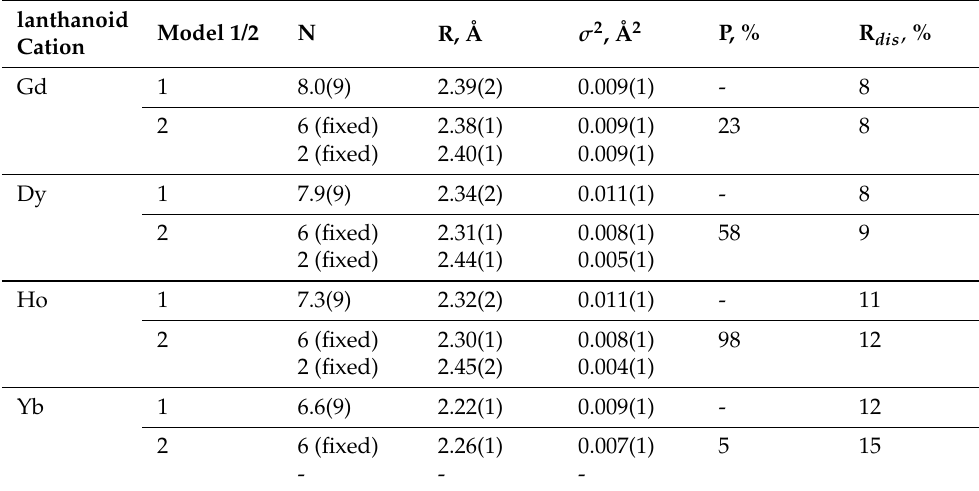
Table 4. Ln L 3 -edge EXAFS best-fit results for Ln -O shells of hydrated well-crystallized Ln WO-1000- 1.5y powders ( Ln = Gd, Dy, Ho,